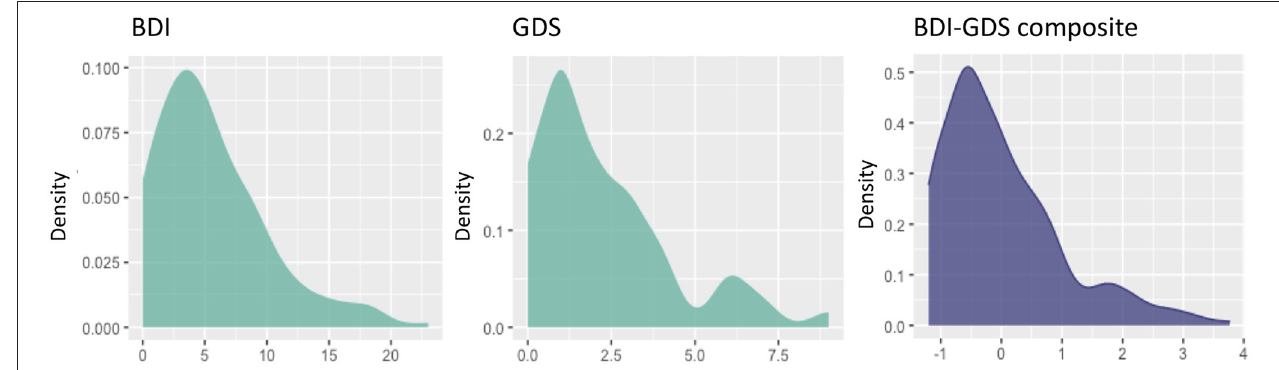
FIGURE 2 | Distribution of the variables of depressive symptomatology. Scores on the x-axis (original scores from the BDI and the GDS, or z-scores from the BDI-GDS composite measure), and densities on the y-axis. BDI, Beck Depression Inventory; GDS, Geriatric Depression Scale.